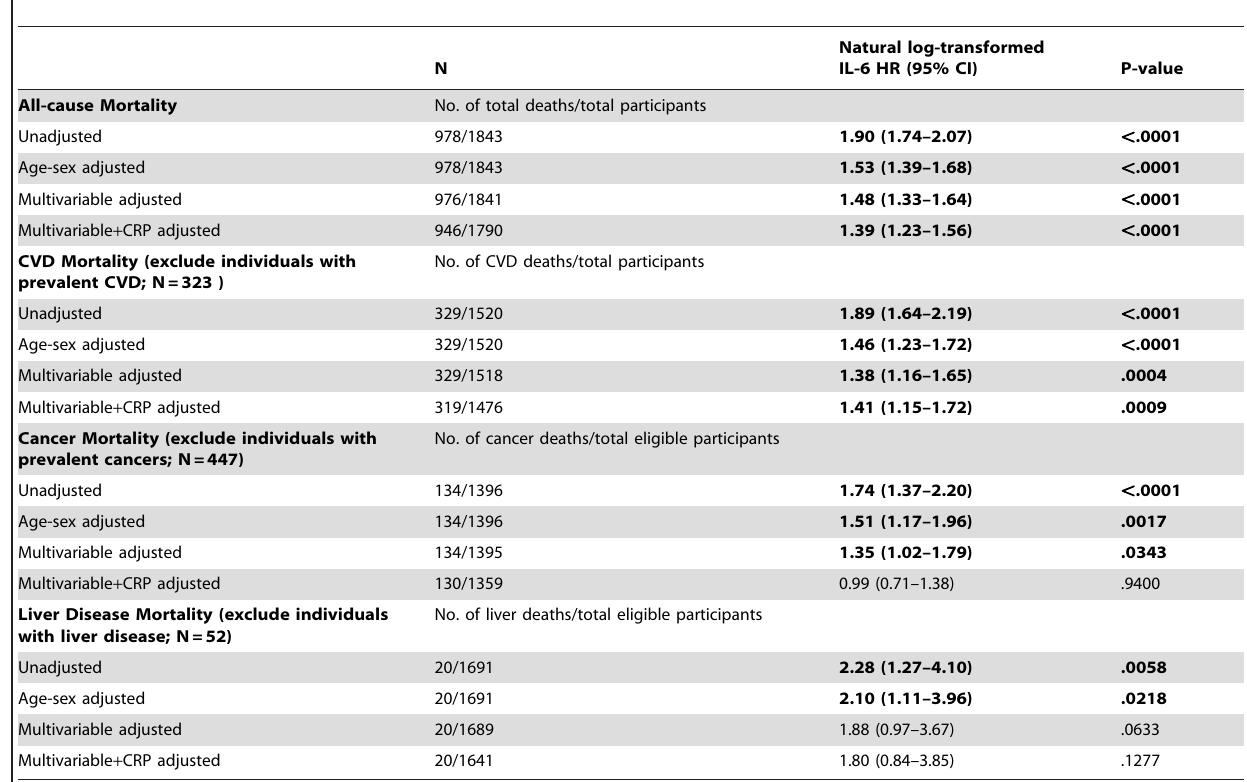
Table 2. The hazards associated with increased IL-6 and risk of all-cause, cardiovascular, cancer, and liver-related mortality in older adults excluding individuals with prevalent CVD, cancer, and liver disease over 15 years of median follow-up.